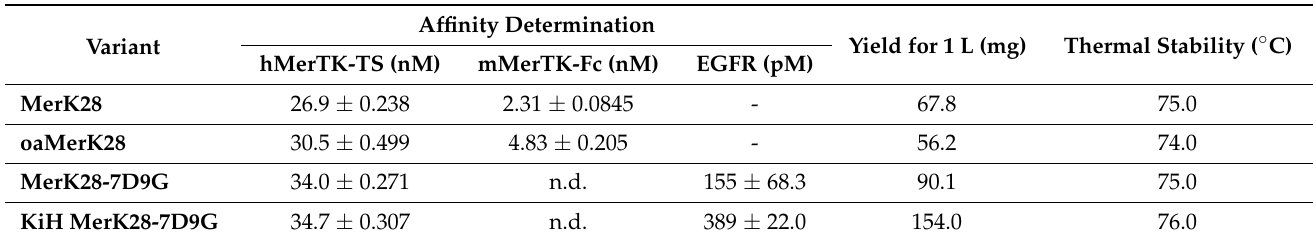
Table 1. Biophysical properties of MerK28 and its derived bispecifics. Abbreviations: TS—Twin- StrepII-Tag, n.d.—not determined.